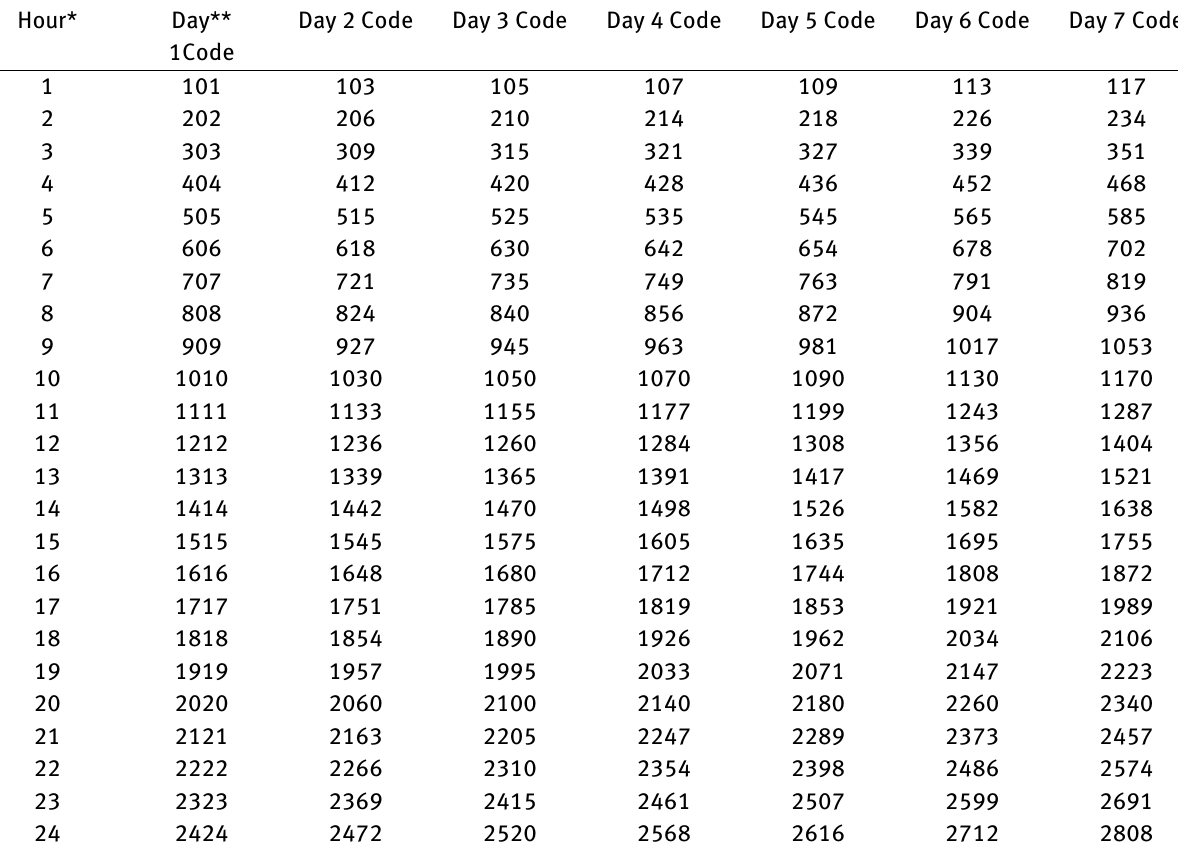
Supplementary Table 3: Codes of the hourly dummy variable